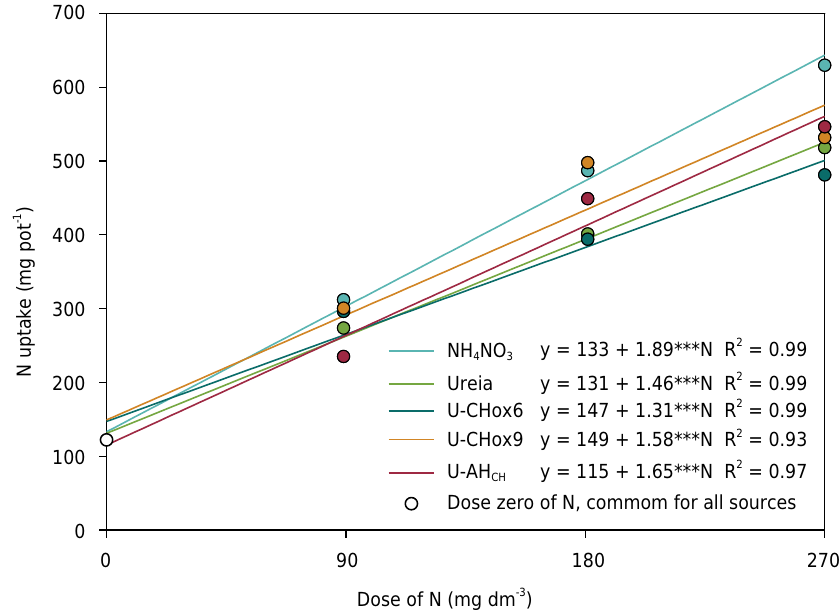
Figure 2. Nitrogen uptake by corn plants as a function of N dosages applied as NH 4 NO 3 , urea, and urea mixed with functionalized charcoals (U-CHox6 or U-CHox9) or humic acids derived from functionalized charcoals (U-AH CH ). Equations representing the observed values are shown for p<0.01